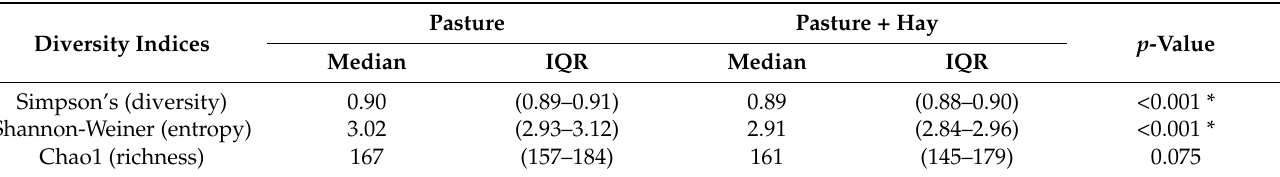
Table 3. Comparison of alpha diversity between